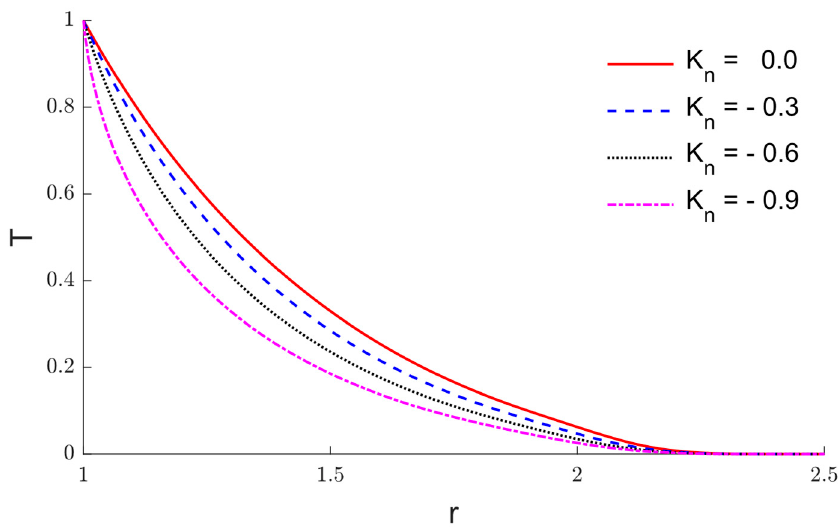
Figure 2. The temperature variations T via r when τ o = 0.05 under varying thermal conductivity.